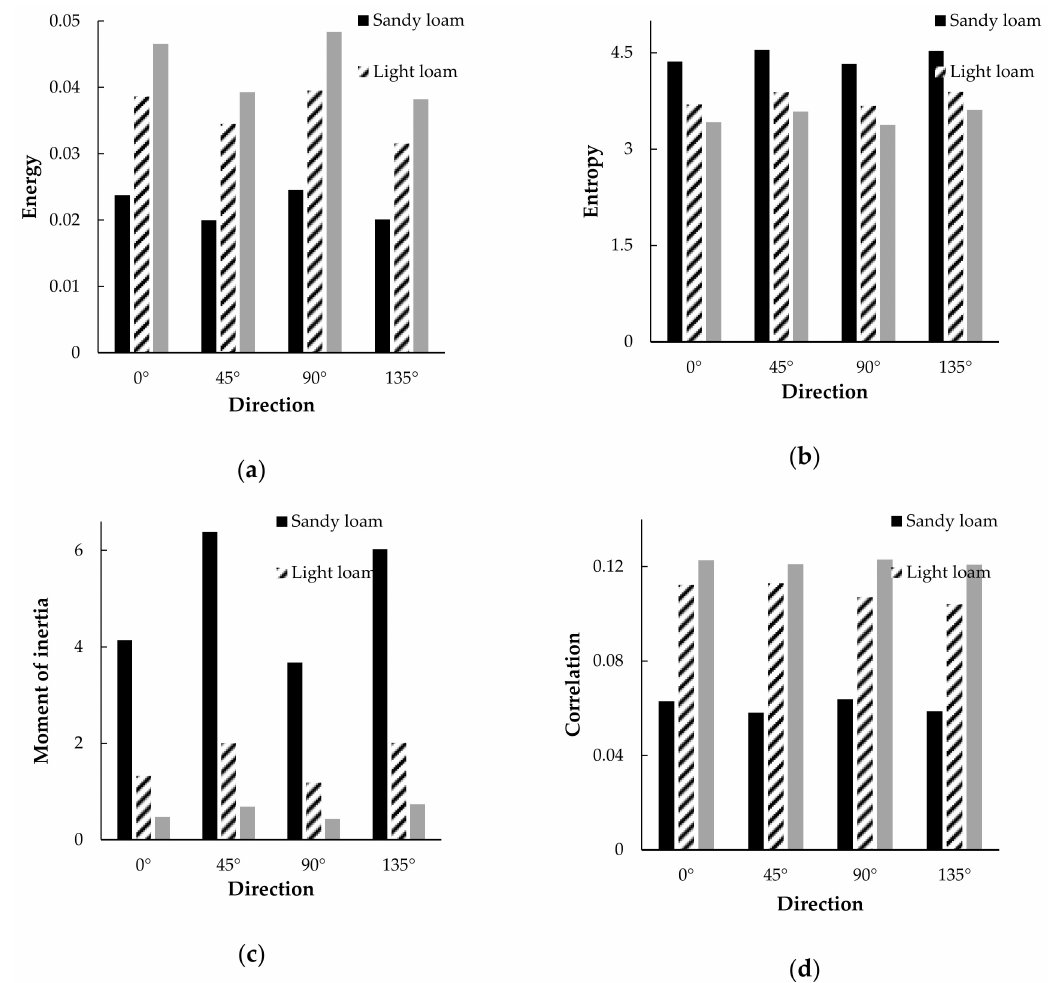
Figure 9. GLCM texture feature average map. ( a ) Average of Energy; ( b ) Average of Entropy; ( c ) Average of Moment of inertia; ( d ) Average of Correlation.